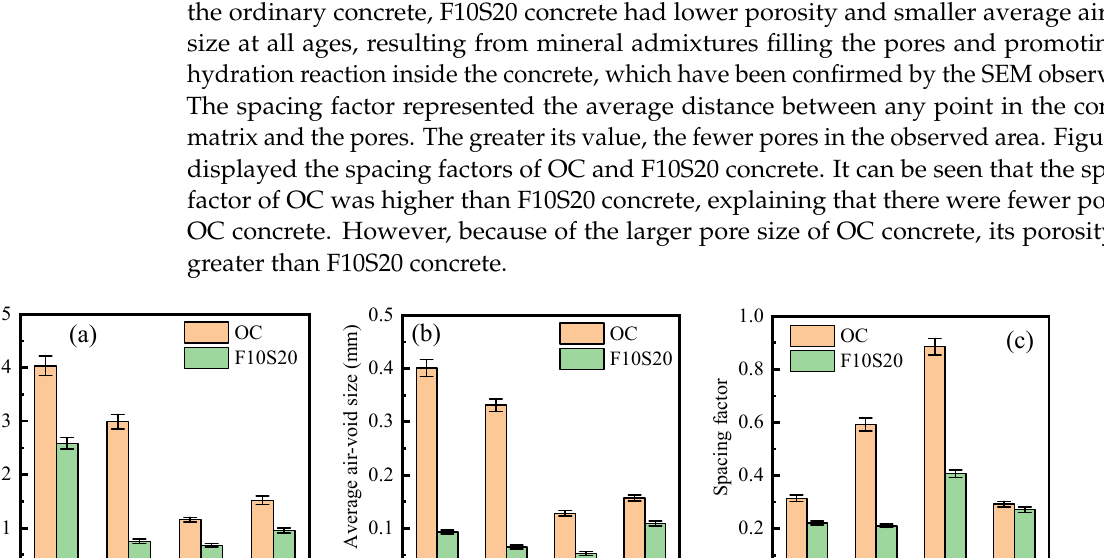
14 of 18 Figure 9. SEM images of OC and F10S20 concrete: ( a ) Microstructure of OC concrete at 3 d; ( b ) Microstructure of F10S20 concrete at 3 d; ( c ) Microstructure of OC concrete at 28 d; ( d ) Microstruc ‐ ture of F10S20 concrete at 28 d; ( e ) ITZ of OC concrete at 28 d; ( f ) Magnified ITZ of OC concrete at 28 d; ( g ) ITZ of F10S20 concrete at 28 d; ( h ) Magnified ITZ of F10S20 concrete at 28 d 3.2.2. Air ‐ void Characteristics To investigate the influence of low humidity and large temperature variation on the